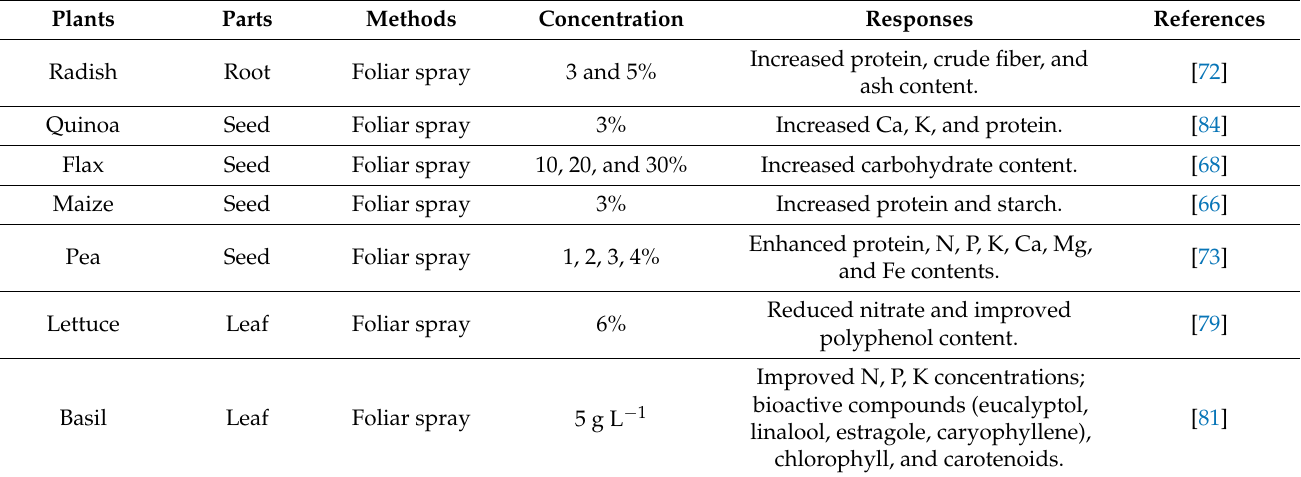
Table 1. Overview of several quality traits of different plants in responses to moringa leaf extract (MLE)